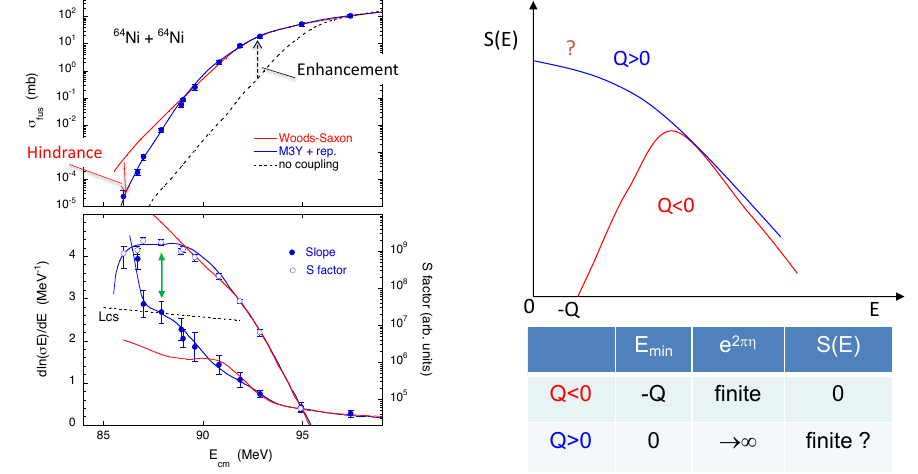
Figure 1. (left) Fusion excitation function, logarithmic slope and S factor for 64 Ni + 64 Ni. (right) Schematic representation of the S factor trend for Q < 0 and Q >